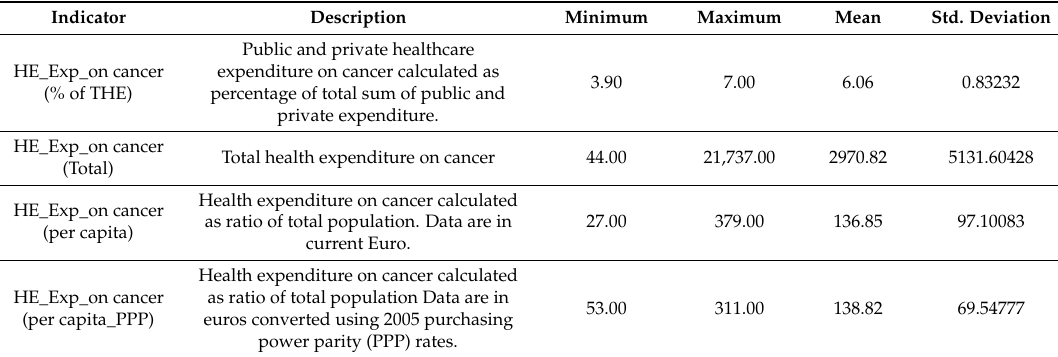
Table 3. Health care expenditure on cancer (28 EU member states),